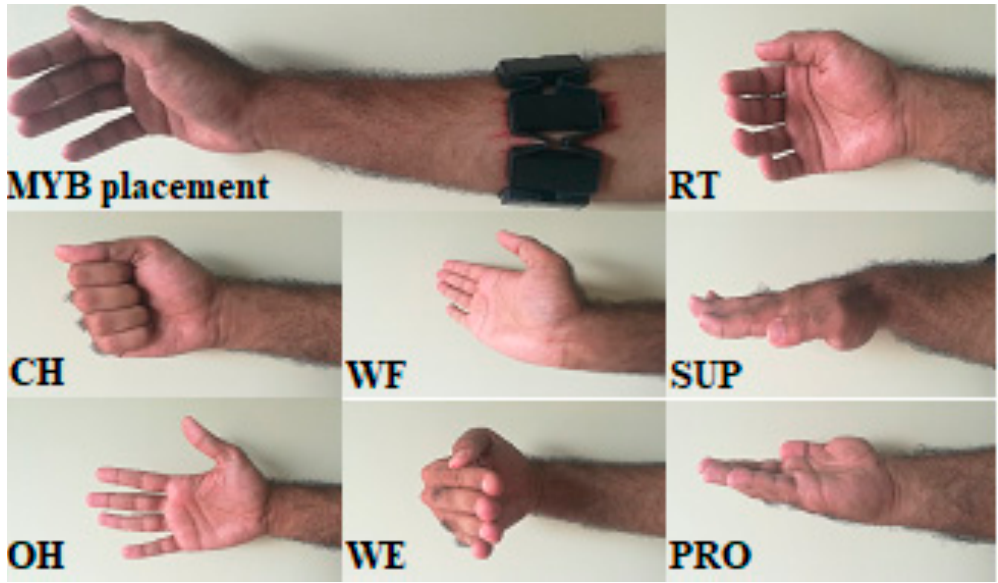
Figure 1. Position of the MYO armband (MYB) on the forearm and different types of motions considered in this work. RT: rest; CH: close hand; WF: wrist flexion; SUP: supination; OH: open hand; WE: wrist extension; and PRO: pronation.